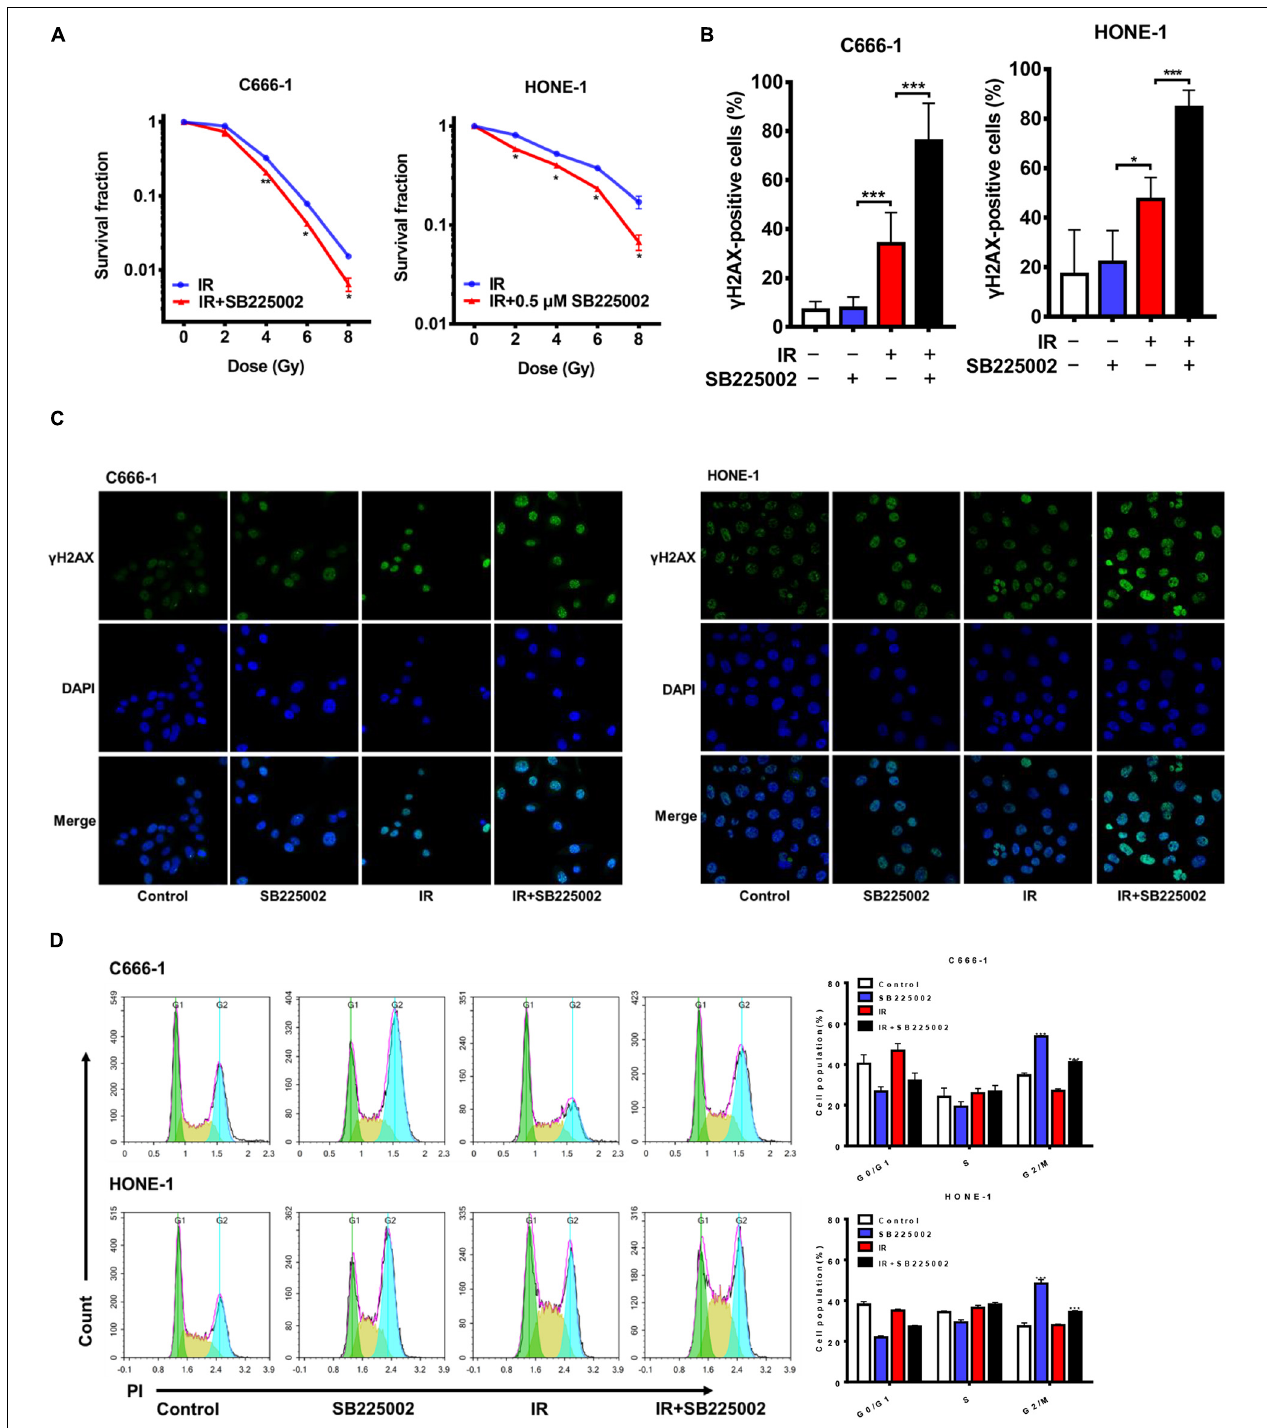
FIGURE 3 | SB225002 sensitizes NPC cells to radiation in vitro . (A) SB225002 sensitized C666-1 and HONE-1 cells to radiation. Cells were treated with 0.5 µ M SB225002 and irradiated with doses as indicated. The colonies were counted 12 days later. Values represent mean ± SD ( n = 3; * p < 0.05; ** p < 0.01; Student’s t -test). (B,C) DSB repair assay was performed by counting γ -H2AX foci. C666-1 and HONE-1 cells pre-treated with SB225002 for 3-4 h were irradiated with 8 Gy and harvested to immunofluorescence stain with DAPI and FITC for γ -H2AX at 1 h later. (C) Representative immunostaining images were shown, 20 × oil. (B) Cells with more than 10 foci were scored as positive and plotted with histograms. Data are shown with the mean ± SD of n = 5-8 fields obtained from three parallel experiments (* p < 0.05; *** p < 0.001; Student’s t-test). (D) Cell cycle distribution analyzed by flow cytometry of PI staining. C666-1 and HONE-1 cells pre-treated with SB225002 for 3-4 h were irradiated with 8 Gy and harvested to analyze by flow cytometry 4 h later ( n = 3; *** p < 0.001; Student’s t -test).